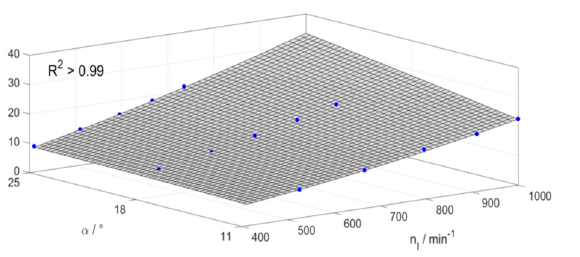
Figure 4. According to Equation (2) the fit shows a high degree of determination with 𝑅 (cid:2870) > 0.99 . For a better prediction of the pass distance outside the given range of 𝑛 (cid:3010) and 𝛼 , the parameter 𝑝 (cid:2868)(cid:2868) can be forced to zero. That is the same as adding an additional forced point to the fitting